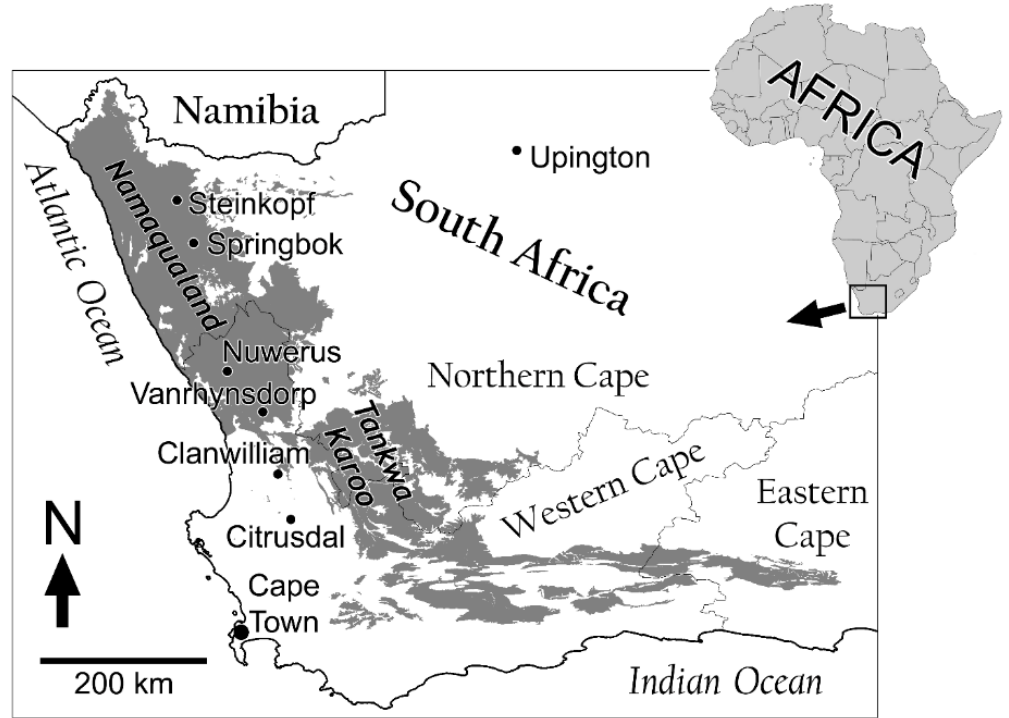
Figure 1. Location of the succulent Karoo (shaded) and place names used in text. Shapefiles for the succulent Karoo boundary from South African National Biodiversity Institute: http://bgis.sanbi.org/ SpatialDataset/Detail/18.